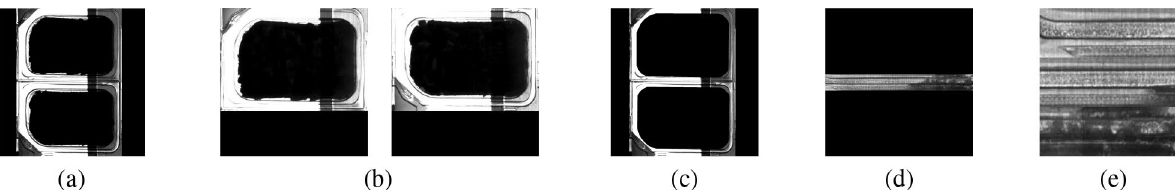
Figure 5. Dataset definition considering the product-based approach and focusing on ( a ) the whole bi-pack product, ( b ) single packs by means of a bi-pack to single pack division, and ( c ) the whole product with a sealing mask; and considering the sealing-based approach and focusing only on ( d ) the pixels in the sealing area (including irrelevant black pixels), and ( e ) the sealing parts obtained after a cutting process and grouped as a sealing